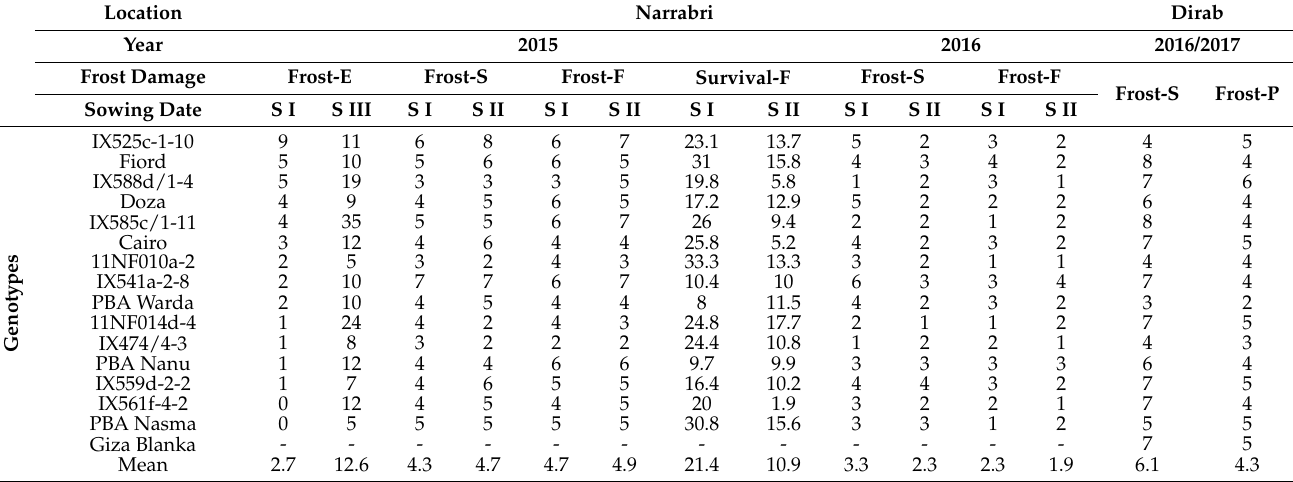
Table 1. Frost damage at different plant growth stages in 2015 and 2016 at the University of Sydney (Narrabri, Australia), and in 2016/2017 at the Agricultural Research Station (Dirab, Saudi Arabia), n = 3. S I, S II, and S III indicate the three sowing dates. Frost-E indicates the number of frost affected plants. Frost-S, Frost-F, and Frost-P indicate frost damage on stems, flowers, and pods, respectively. Survival-F is the percentage of frost affected flowers that produced pods. Frost-E was evaluated by counting the number of damaged plants 20 m − 2 , while Frost-S, Frost-F, and Frost-P were determined using a visual 1–9